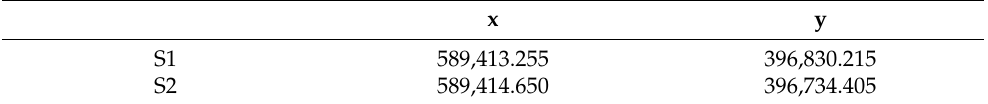
Table A2. Coordinates of S1 and S2.